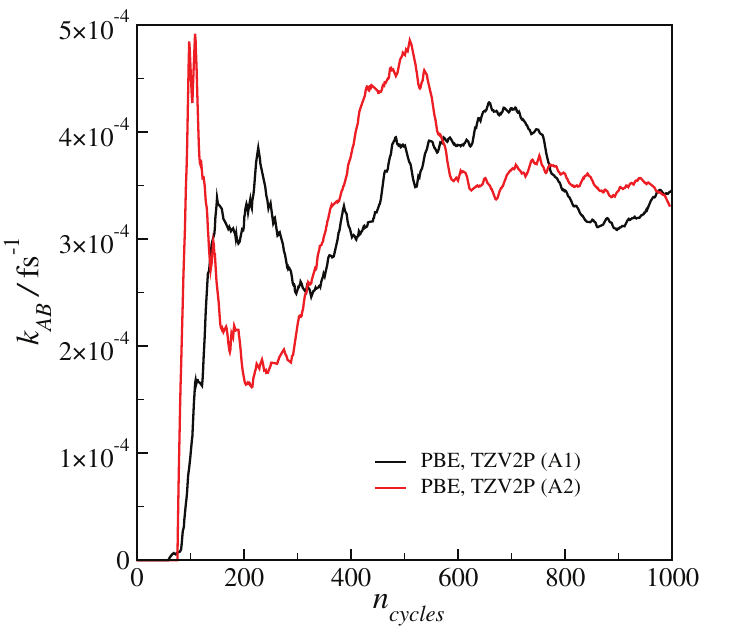
Figure 3 Plot of the calculated fi nal reaction rate k AB as a function of the RETIS cycle n cycle for the two calculations with the PBE functional and the TZV2P basis